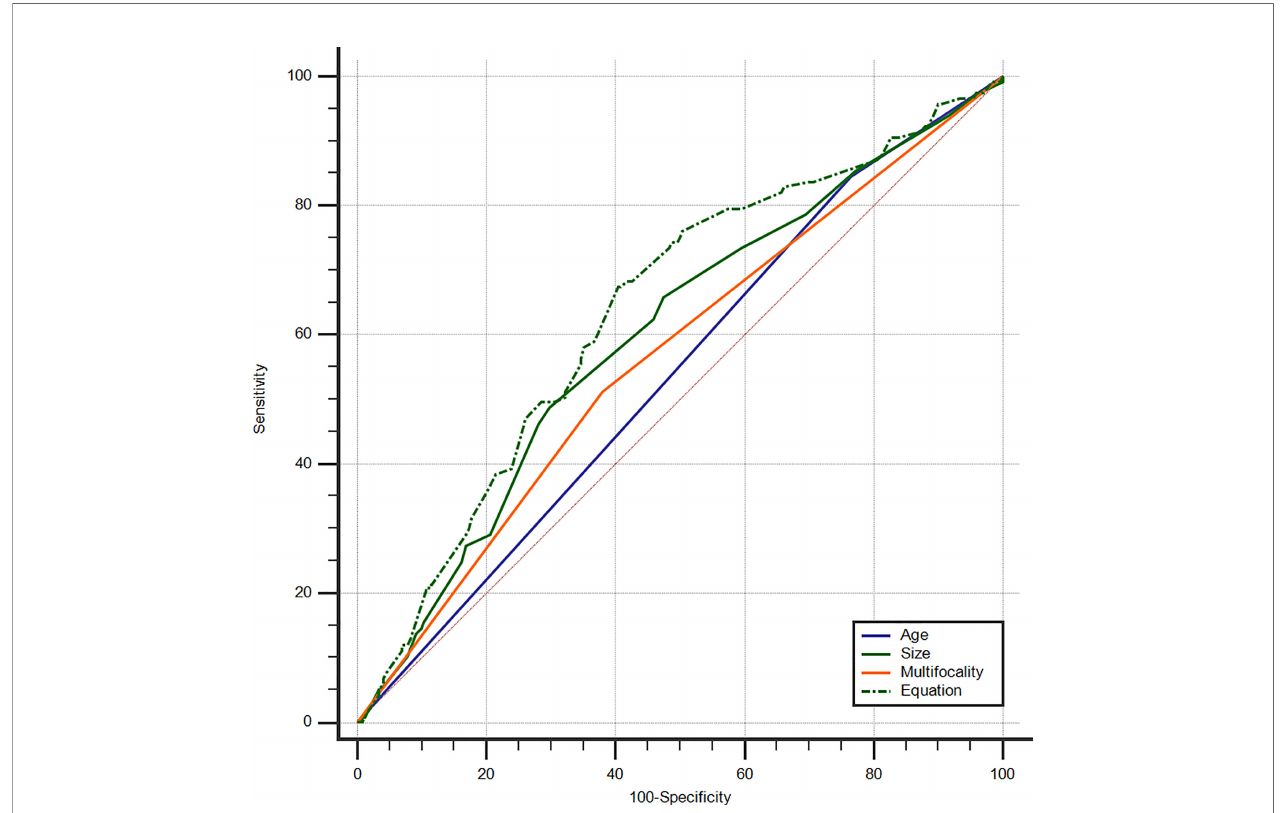
FIGURE 4 | ROC curves of PTC age (AUC=0.541), size (AUC=0.601), multifocality (AUC=0.566), and Equation (AUC=0.639) for the prediction of microscopic pN1. ROC, receiver operating characteristic; PTC, papillary thyroid carcinoma; AUC, area under the curve; Microscopic pN1, microscopic pathological N1.